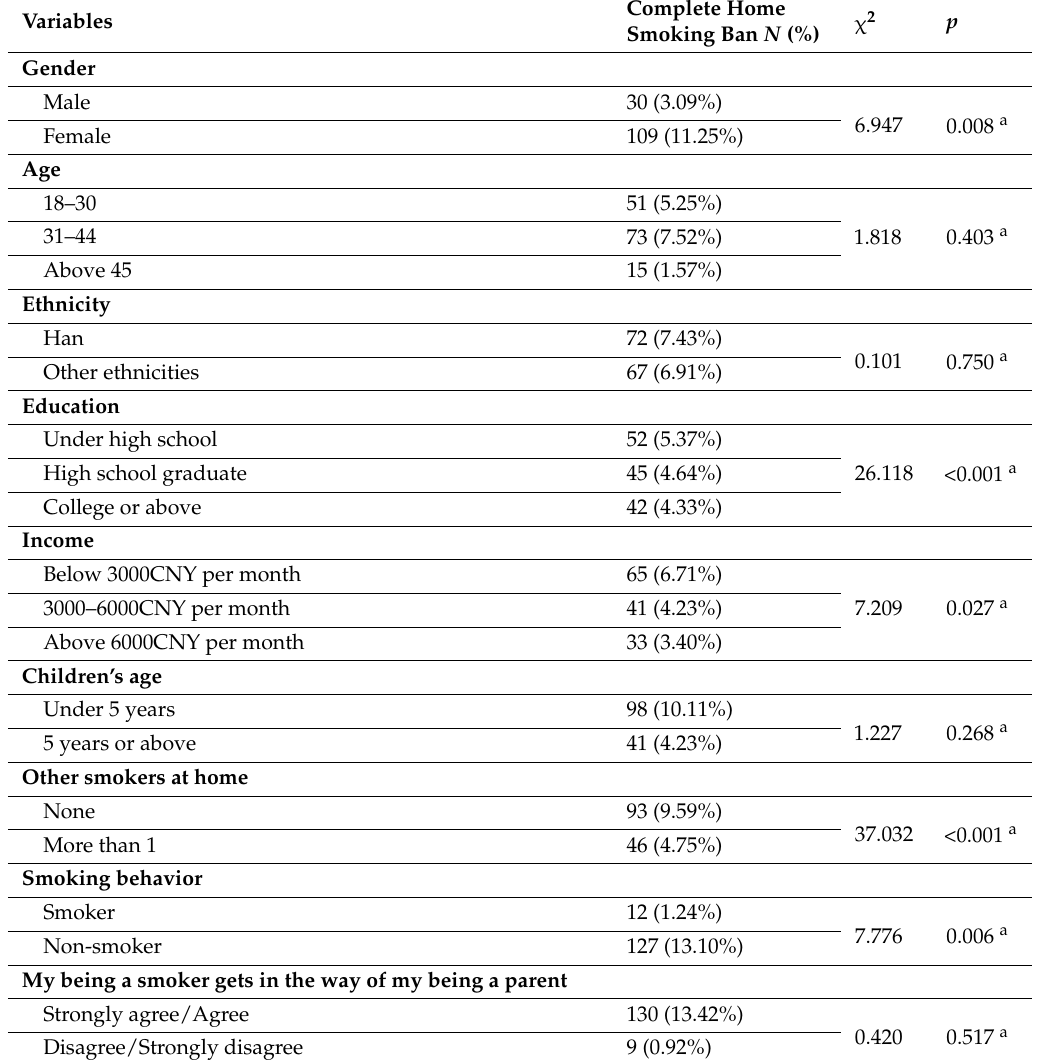
Table 2. Complete home smoking bans by selected characteristics ( N =